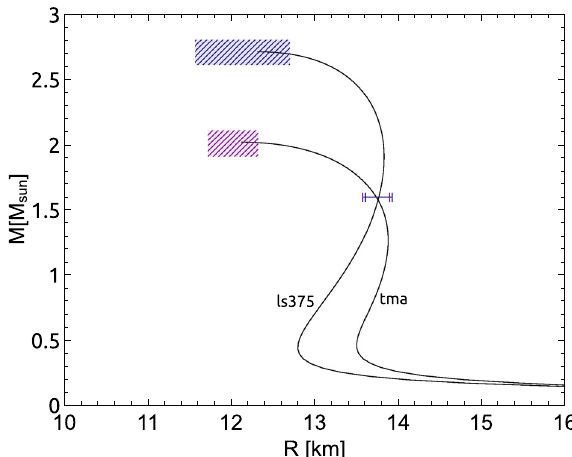
Fig. 36 Mass-radius relations for two EOSs with similar stellar properties in the intermediate mass range around 1 . 6 M (cid:3) where the two mass-radius relations cross. Bars at 1 . 6 M (cid:3) indicate the maximum deviation of the estimated radius inferred from a single GW detection of a low-mass binary NS merger. Using the extrapolation procedure described in Bauswein et al. (2014) the two EOSs can clearly be distinguished. Boxes illustrate the maximum deviation of the estimated properties of the maximum-mass configuration. (Image reproduced with permission from Bauswein et al. 2014, copyright by